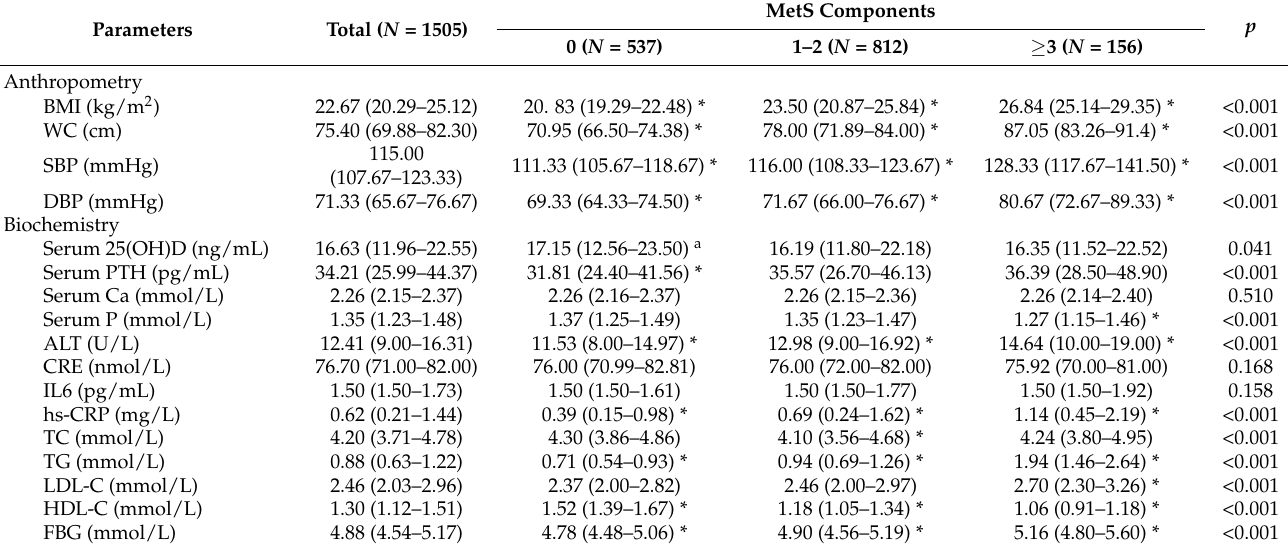
Table 2. Clinical characteristics according to the number of MetS’s